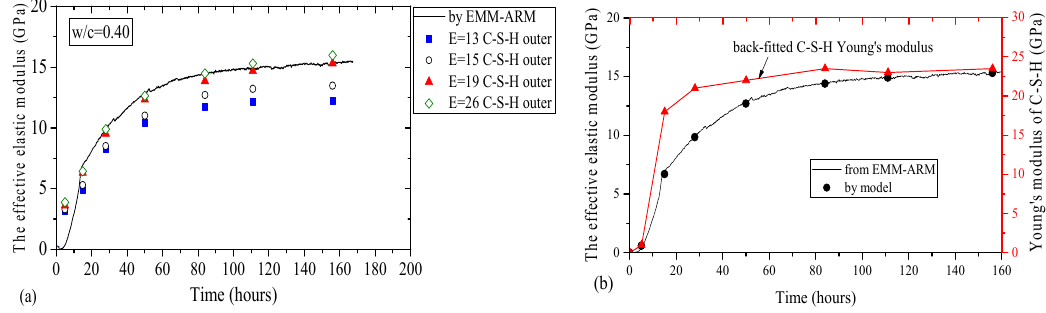
Figure 16. Effective Young’s modulus of the cement paste in REV: ( a ) influence of the outer C-S-H Young’s modulus; ( b ) influence of the average Young’s modulus of C-S-H when it is assumed as a single-phase product with no division to inner and outer.